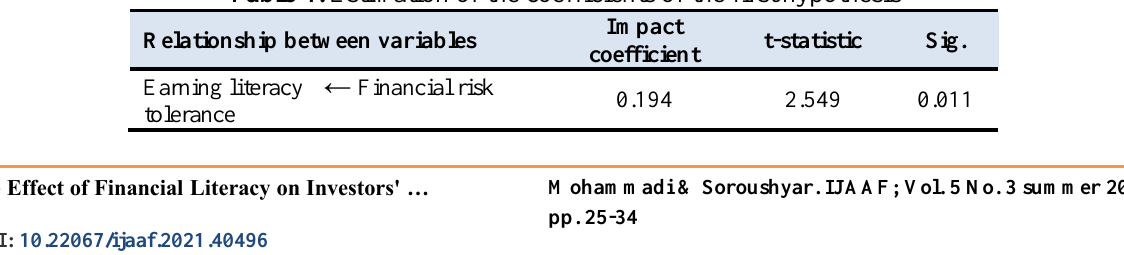
Table 4. Estimation of the coefficients of the first